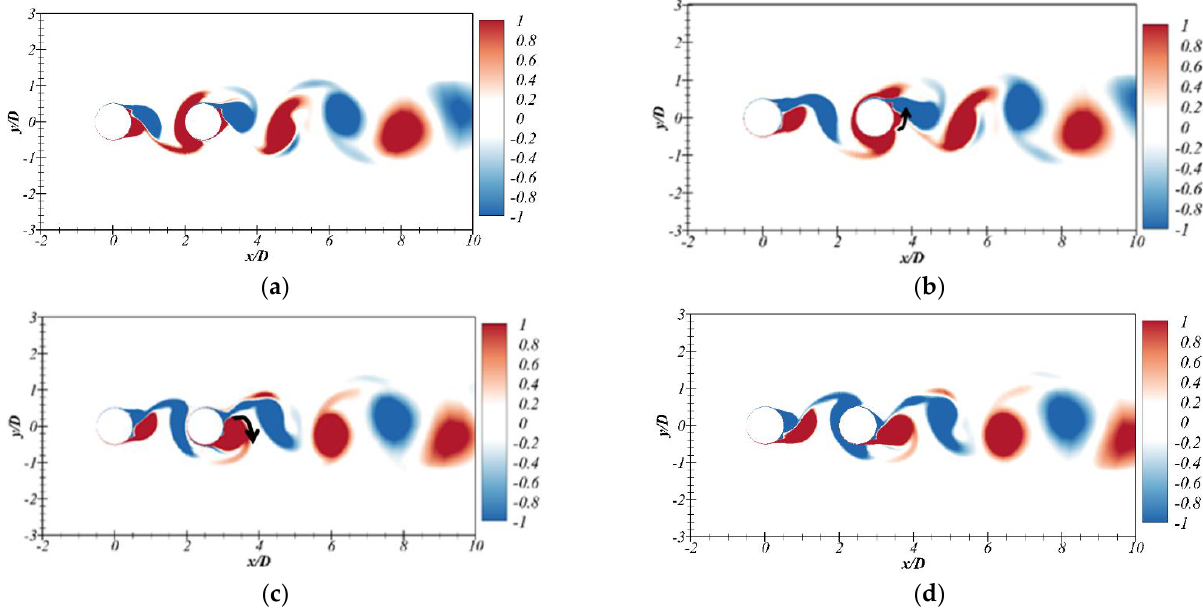
Figure 10. The contours of the spanwise vorticities for 𝐿/𝐷 = 2.5 : ( a ) 𝑡𝐷/𝑈 ∞ = 279.5 ; ( b ) 𝑡𝐷/𝑈 ∞ = 281 ; ( c ) 𝑡𝐷/𝑈 ∞ = 280 ; ( d ) 𝑡𝐷/𝑈 ∞ = 281 . ( b ) tD / U ∞ = 281; ( c ) tD / U ∞ = 280; ( d ) tD / U ∞ =